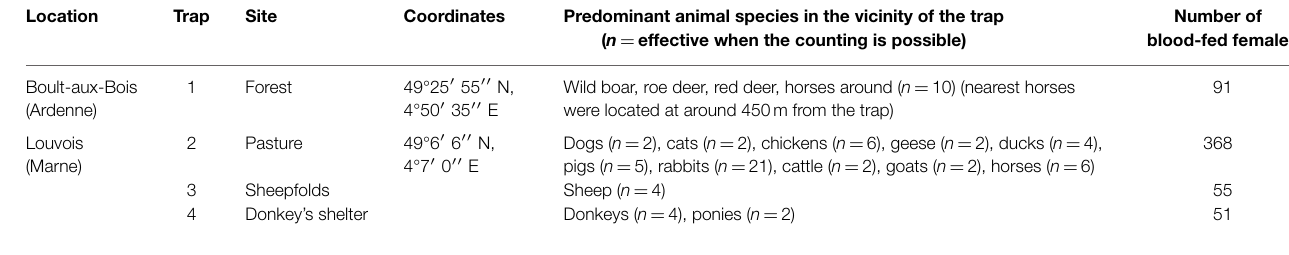
TABLE 1 | Sample of blood-fed Culicoides in this study . Location Trap